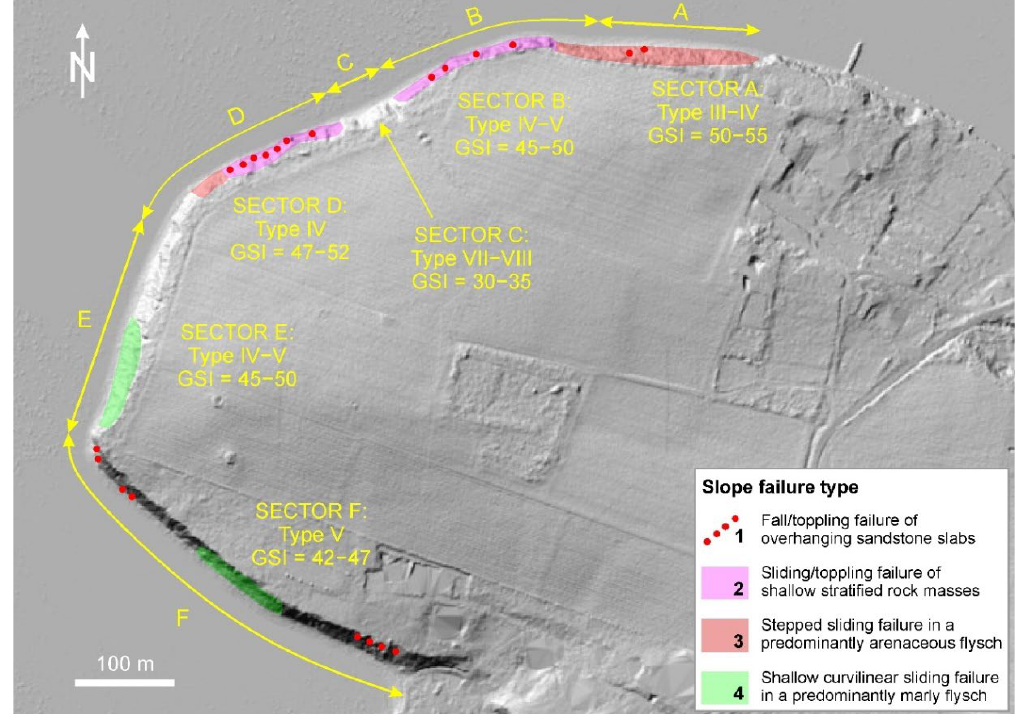
Figure 17. Map of instability phenomena occurring at Debeli Rtič showing the different slope failure types (1 – 4) involving various sectors ( A – F ) of the Flysch Sea cliff. types (1–4) involving various sectors ( A – F ) of the Flysch Sea